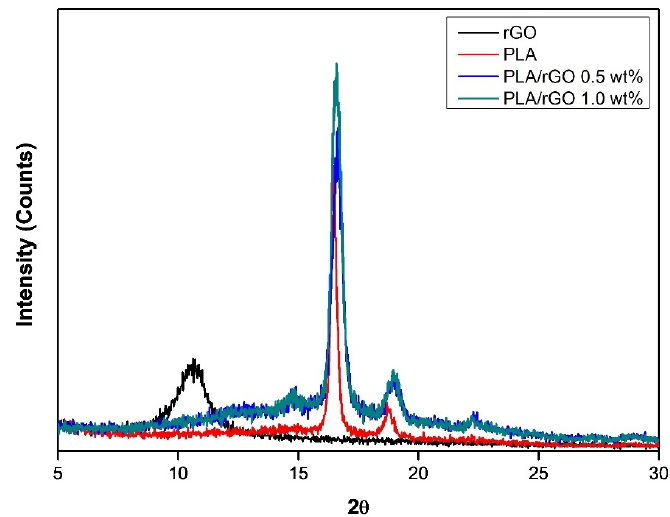
Figure 7. XRD patterns of rGO, pure PLA, PLA/rGO 0.5wt%, and PLA/rGO 1.0 wt%. The Raman spectra of PLA/rGO 0.5 wt% and PLA/rGO 1.0 wt% are shown in Figure 8. The intensity of the D band (around 1400 cm − 1 ) and G band (around 1600 cm − 1 ) corre- sponded to the vibrations of the sp 3 -bonded carbon atoms and sp 2 -bonded carbon atoms, respectively. As already known, the D band reflects disordered structures (such as defects, crystal boundaries, and so on), while the G band reflects the crystalline structures [40]. The intensity ratios of the D band and G band ( I D / I G ) for PLA/rGO 0.5 wt% and PLA/rGO 1.0 wt% were 0.93 and 0.99, respectively, which were significantly higher than that of pure graphite [41], because GO was successfully exfoliated after reduction. In addition, there was no 2D band between 2600 cm − 1 and 2800 cm − 1 , indicating no stacked graphene layers. Figure 8. Raman spectra of PLA/rGO 0.5 wt% and PLA/rGO 1.0 wt%.